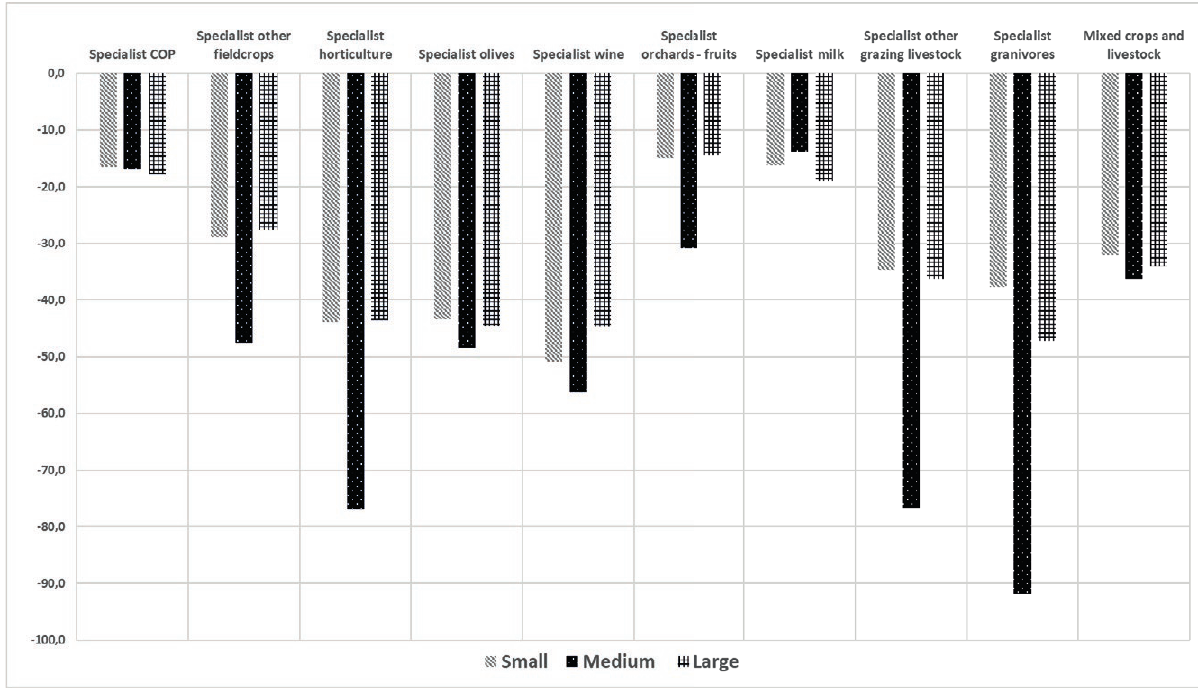
Figure 6. Changes in the ratio AV/AWU based on the estimated variations of Total Farm Revenues. Source: own elaboration on collected data.